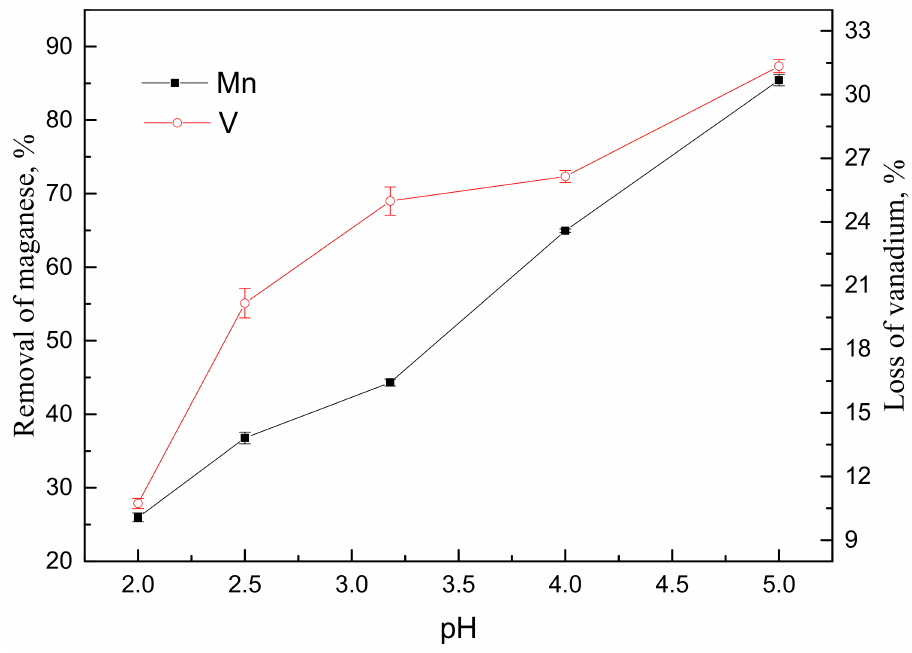
Figure 15. Effect of pH value of aqueous solution on the removal of manganese and the loss of